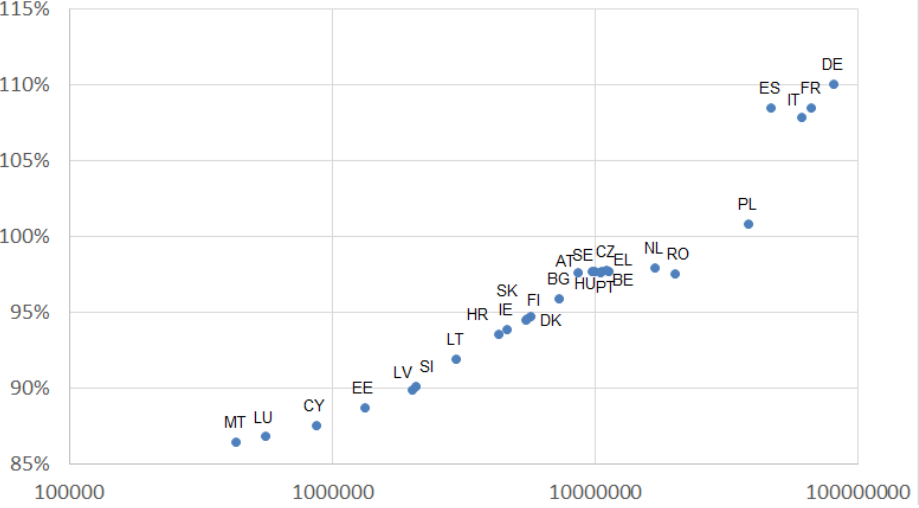
Figure 1. Adjusted power indices as a percentage of the pre-Brexit power indices at 2015 population levels labelled by EU country